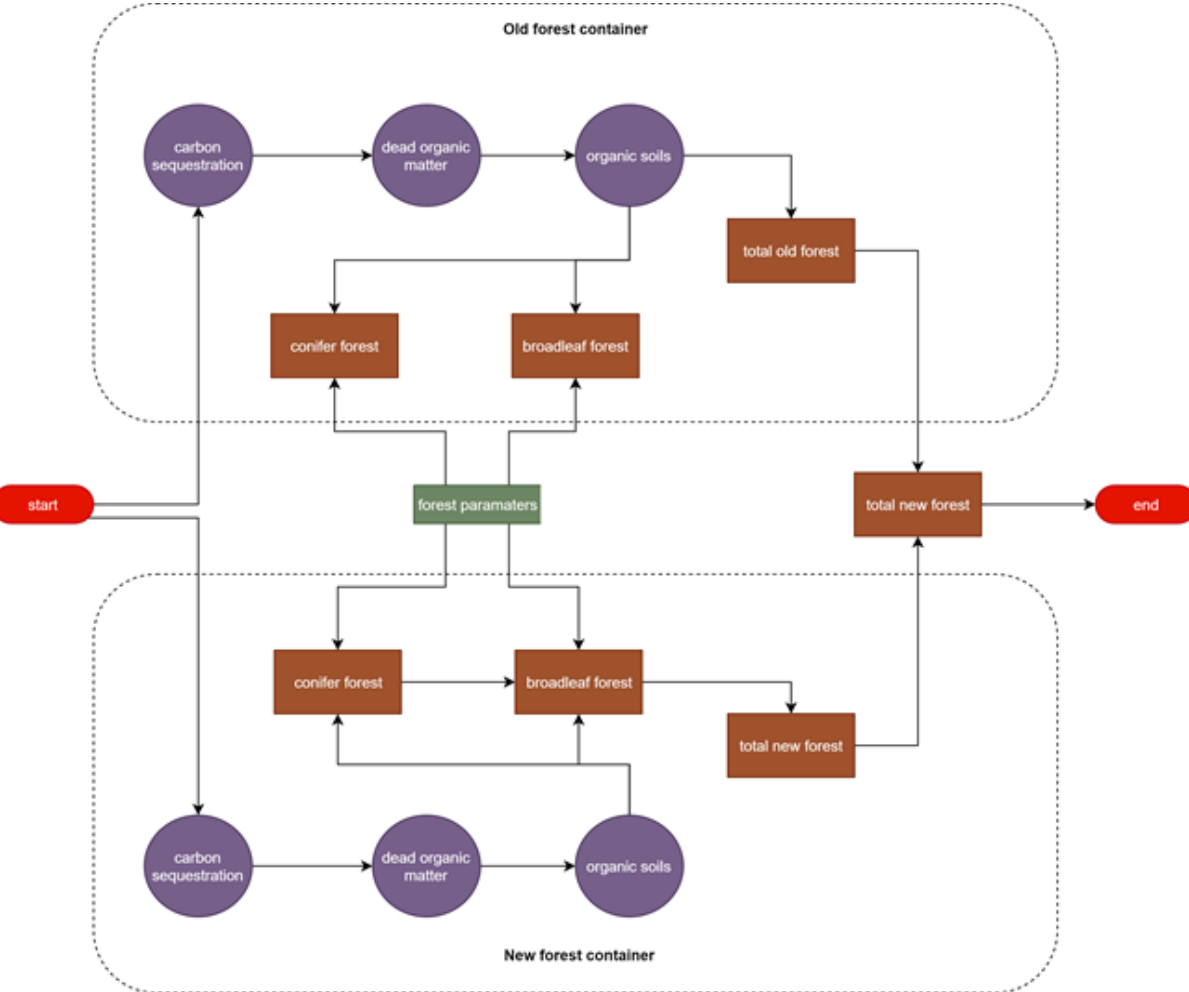
Figure 5. GOBLIN forest module calculation methodology. Arrows represent data flow. Modules are represented by brown rectangles, processes are represented by purple circles, and open-ended green rectangles represent data stores.